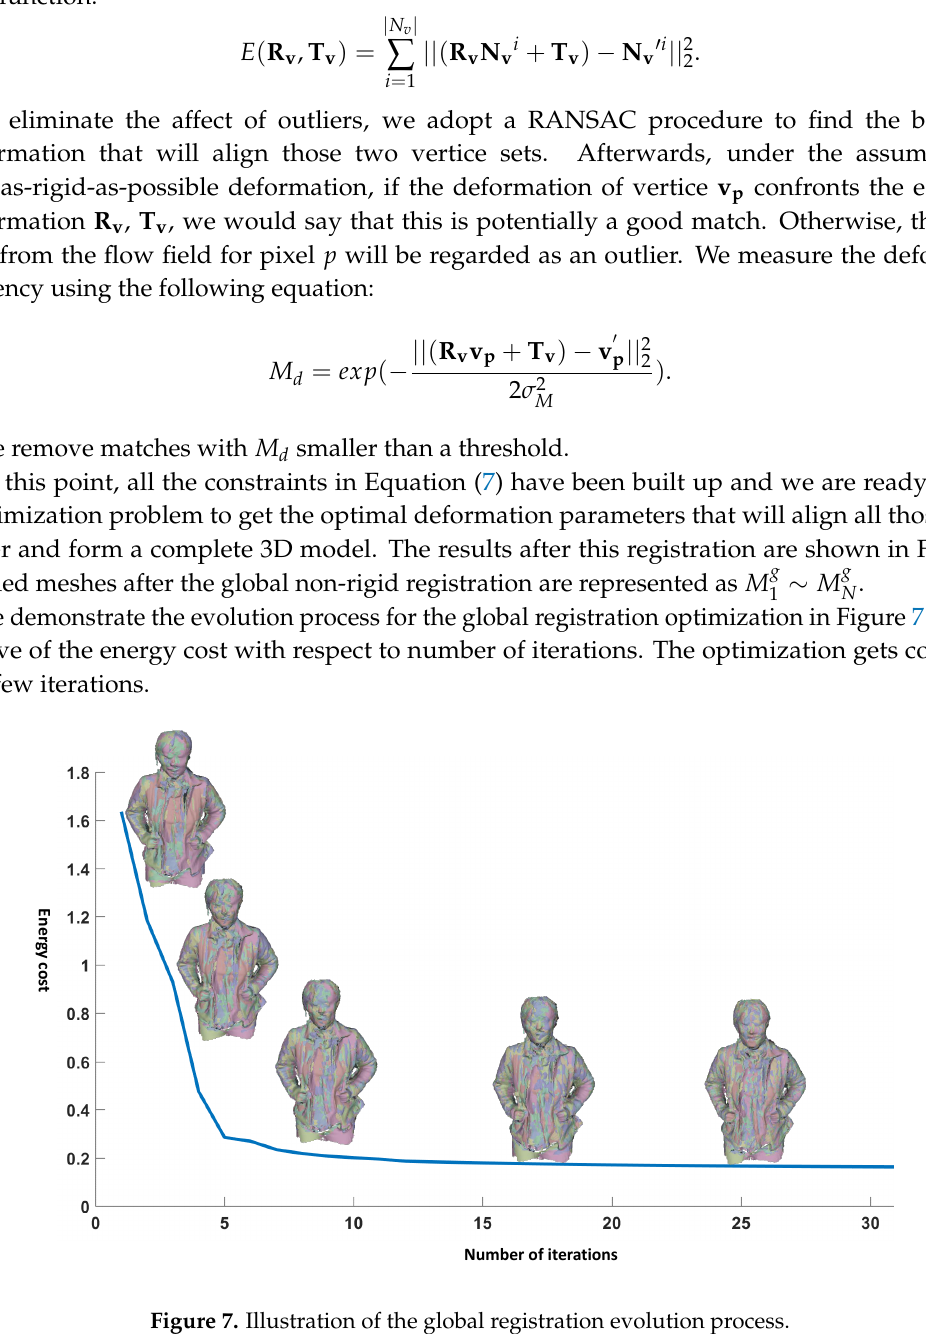
Figure 7. Illustration of the global registration evolution